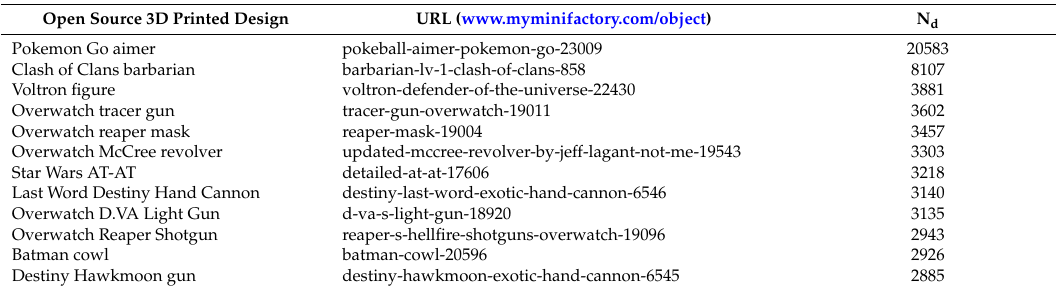
Table 1. Most popular designs downloaded on MyMiniFactory in January